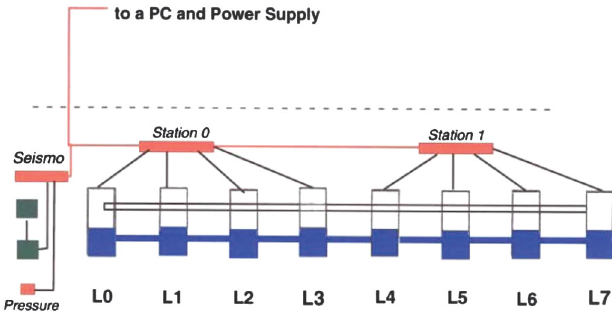
FIG. 32. (Color) Schematics of the systems of HLS sensor used in the studies in Illinois.